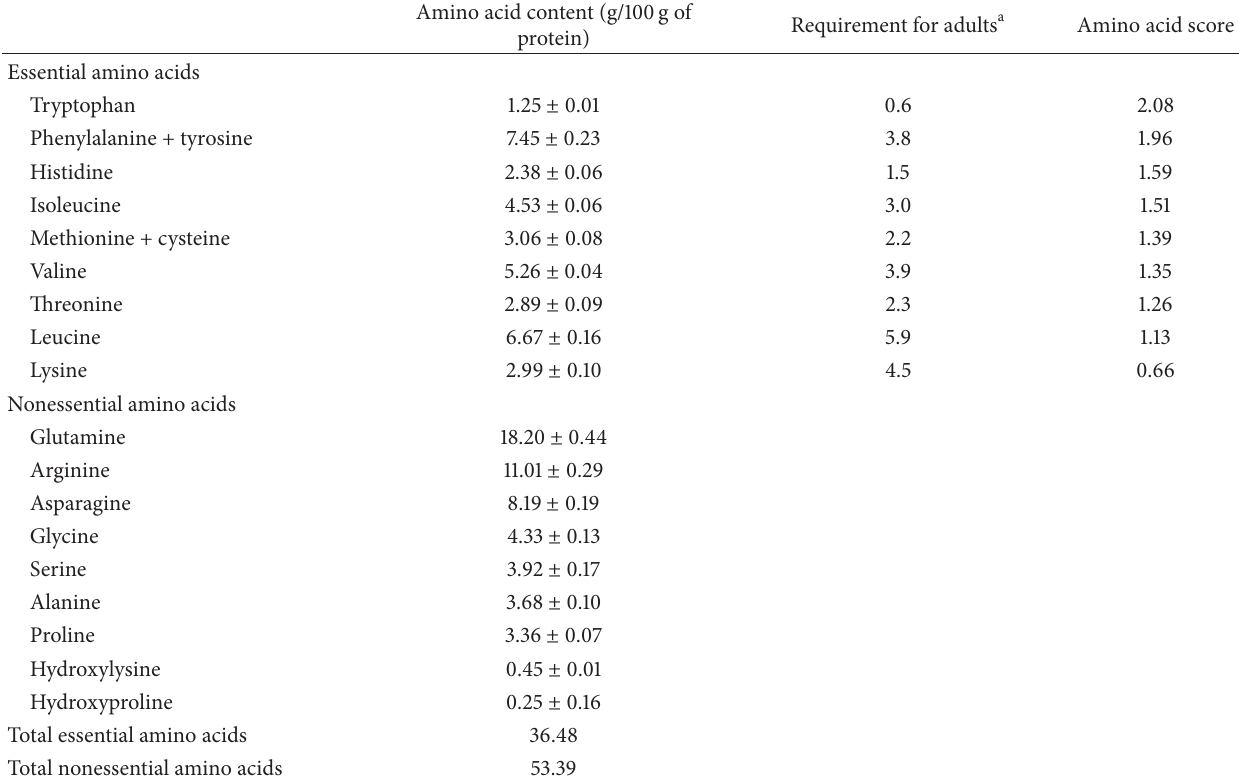
Table 2: Amino acid content of seed flour from Lannea kerstingii